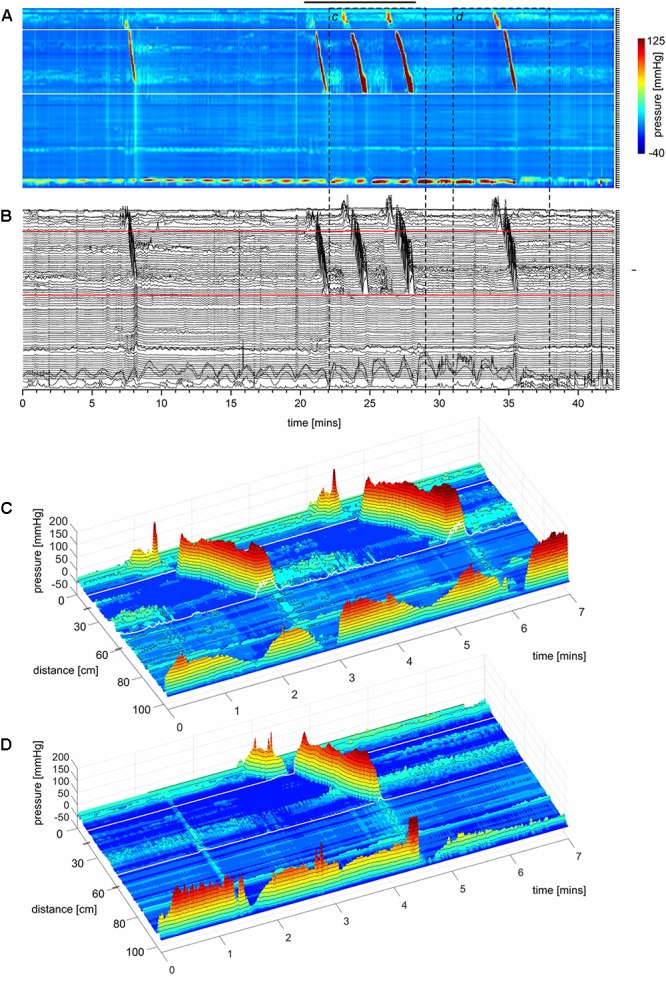
A HAPW that develops into a SPW in response to proximal balloon distention, the HAPW-SPW. In this and all other figure panels, the position of a balloon is indicated by a white line. This means that there are 10 cm gaps in this recording at the two white lines. Hence a recording including 80 sensors will have a total reach of 100 cm. In (A,B), the dashes at the right side of the figure represent the position of the sensors (80 sensors were in the colon, spaced 1 cm apart). The proximal colon is at the top of the figures. In (C,D) on the distance axis, 0 is the location of the most proximal sensor. (A) The time period of proximal balloon distention by 240 ml air is indicated by the black line above (A). The balloon is positioned at the proximal white line. Proximal HAPWs developed into SPWs (generating HAPW-SPWs) associated with extensive anal sphincter relaxation. Extensive haustral activity (see Chen et al., 2017; Quan et al., 2017) is seen between 30 and 35 cm following each HAPW. (B) Same as (A), shown are the actual pressure traces. (C) Section of (A) between the first two vertical dashed lines show two HAPW-SPWs that are followed by anal sphincter relaxation. Note that the HAPW evoked by the balloon starts at the most proximal sensor or more proximal. (D) Section of (A) between the 3rd and 4th vertical dashed lines. A low amplitude SPW with anal sphincter relaxation is seen at 1.8 cm. This is followed by an HAPW-SPW and anal sphincter relaxation; the relaxation is preceded by a brief voluntary external anal sphincter contraction. The subject was asked a minute after the motor pattern occurred whether or not the sphincter was voluntarily squeezed. The first HAPW-SPW during balloon distention was associated with bloating, the second with a feeling of urgency. The HAPW-SPW that occurred ∼5 min after balloon distention was associated with urgency. The SPW was not associated with gas or liquid expulsion.